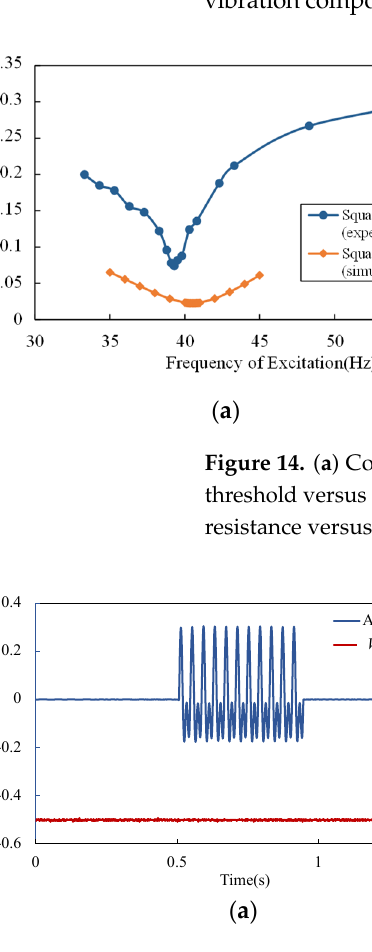
Figure 14. ( a ) Comparison of the simulation result and the experimental result of the acceleration threshold versus the excitation frequency; ( b ) experimental results of the contact time and the con- tact resistance versus the excitation acceleration.